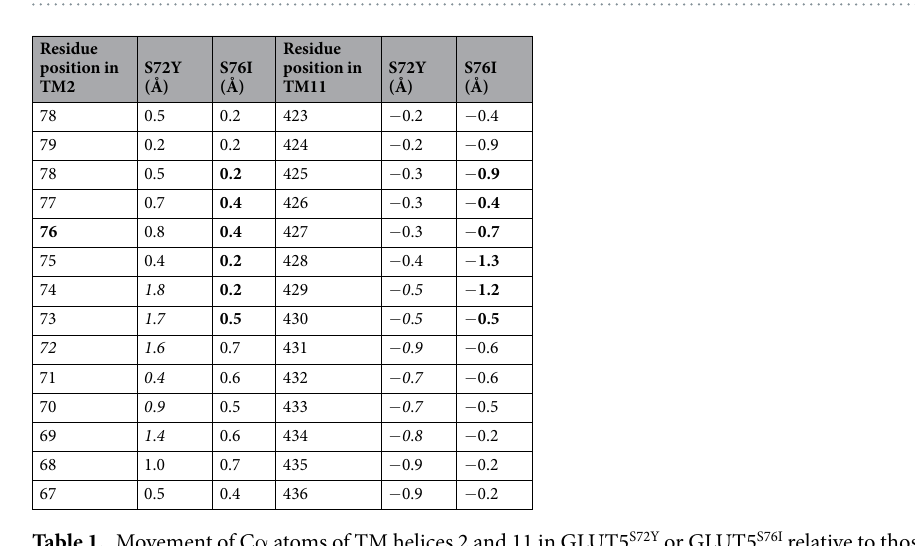
Figure 2. Structural models of GLUT5 S72Y and GLUT5 S76I mutants. Outward-facing ( a ) and inward-facing ( b ) structures of mutants. S72 and S76 are located toward the lumen in TM helix 2. Close-up showing the location of Y72 and I76 in the outward-facing ( c ) and inward-facing ( d ) conformations of the transporter. Y72 and I76 interact with hydrophobic residues from TM helix 11. Figure was generated with Molscript 47 and Raster3D 48 .